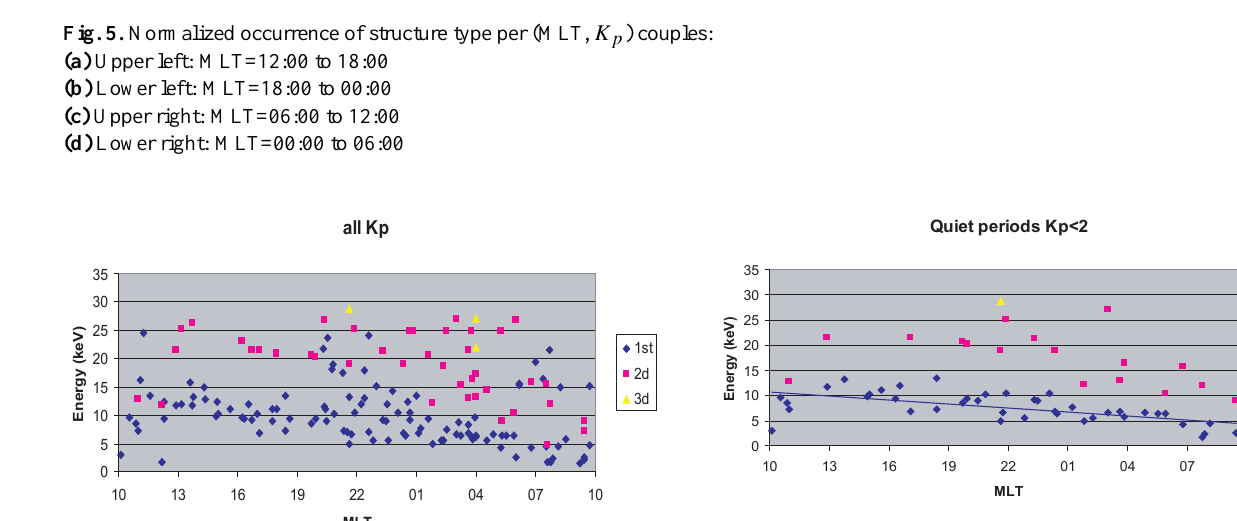
MLT=0 to 6: Fig. 5. Normalized occurrence of structure type per (MLT, K p ) couples: